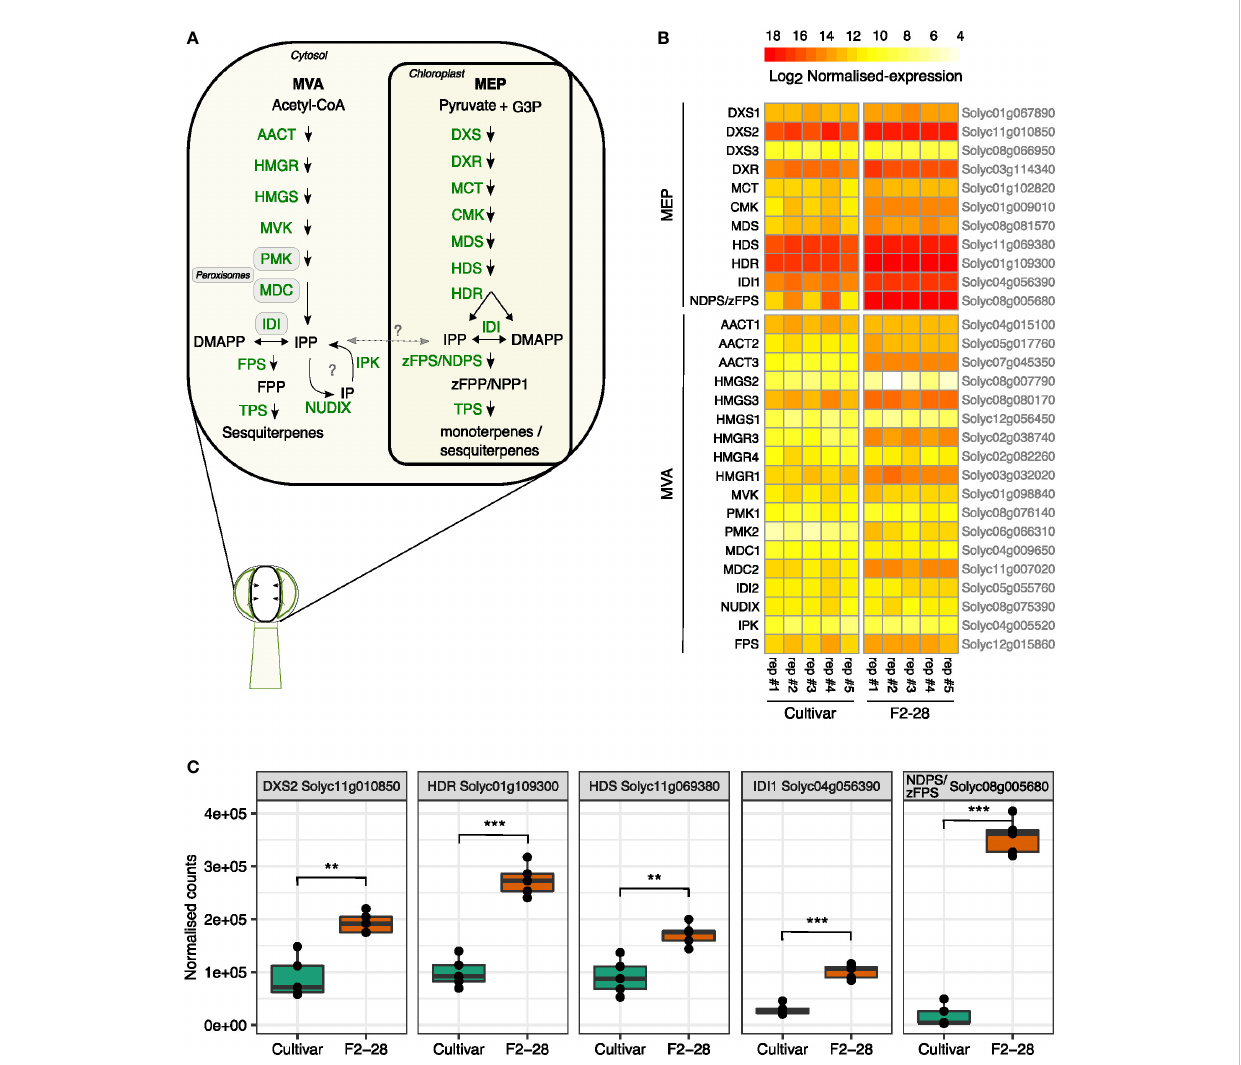
FIGURE 6 Gene expression patterns of the MEP and MVA pathway in secretory cells of F2-28 and the cultivar. (A) A schematic overview of the MEP and MVA pathway for mono-and sesquiterpene synthesis in the secretory cells of type-VI trichomes of tomato. Each arrow arrows indicates one enzymatic step. Metabolites are indicated in black, enzymes in green. Question marks indicate hypothetical steps that are not validated in tomato trichomes. (B) Heatmap showing the normalised counts (Log 2 transformed) of transcripts obtained by mRNA-sequencing of secretory cells of type-VI trichomes isolated from the leaves of the cultivar (n = 5) and F2-28 (n = 5) cuttings. Plotted are transcripts mapping to the different homologous enzymes of the MEP and MVA pathway as encoded by genes in the S. lycopersicum genome (Heinz). Gene annotations are given on the left side of the heatmap, gene annotations are given on the right. (C) Boxplots of the normalised counts of the highest expressed genes in the MEP pathway of the cultivar and F2-28. Each dot represents one biological replicate. Asterisks show signi fi cant differences in expression (T-test) with ** p < 0.01 and *** p < 0.001. Enzyme abbreviations: 1-deoxy-d-xylulose 5-phosphate synthase (DXS); 1-deoxy-d-xylulose 5-phosphate reductoisomerase (DXR); 2- C-methyl-d-erythritol 4-phosphate cytidylyltransferase (MCT); 4-(cytidine 5 ′ -diphospho)-2-C-methyl-D-erythritol kinase (CMK); 2-C-methyl-d- erythritol 2,4-cyclodiphosphate synthase (MDS); ( E )-4-hydroxy-3-methylbut-2-enyl diphosphate synthase (HDS); ( E )-4-hydroxy-3-methylbut-2-enyl diphosphate reductase; (HDR); isopentenyl diphosphate isomerase (IDI); Z-Z -farnesyl diphosphate synthase (zFPS); neryl diphosphate synthase (NDPS); terpene synthase (TPS); acetyl-CoA C-acetyltransferase (AACT); 3-hydroxy-3-methylglutaryl-CoA synthase (HMGS); 3-hydroxy-3- methylglutaryl-CoA reductase (HMGR); mevalonate kinase (MVK); phospho-mevalonate kinase (PMK); mevalonate-5-diphosphate decarboxylase (MDC); isopentenyl phosphate kinases (IPK); nudix hydrolase (NUDIX); farnesyl diphosphate synthase (FPS). Metabolite abbreviations: glyceraldehyde 3-phosphate (G3P); isopentenyl phosphate (IP); isoprene diphosphate (IPP); dimethylallyl diphosphate (DMAPP); neryl diphosphate (NPP); farnesyl diphosphate (FPP); Z-Z -farnesyl diphosphate